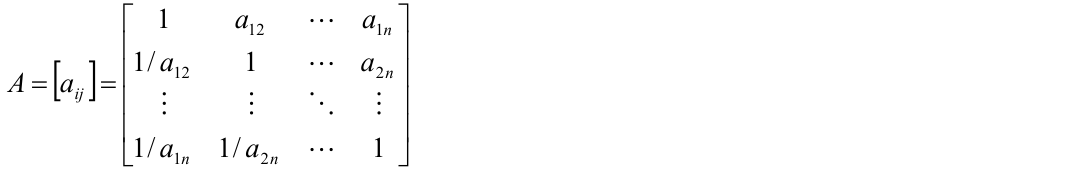
Saaty's 1-9 scale Intensity of importance Definition 1 Equal importance 3 Moderate importance 5 Strong importance 7 Very strong importance 9 Extreme importance 2, 4, 6, 8 Intermediate